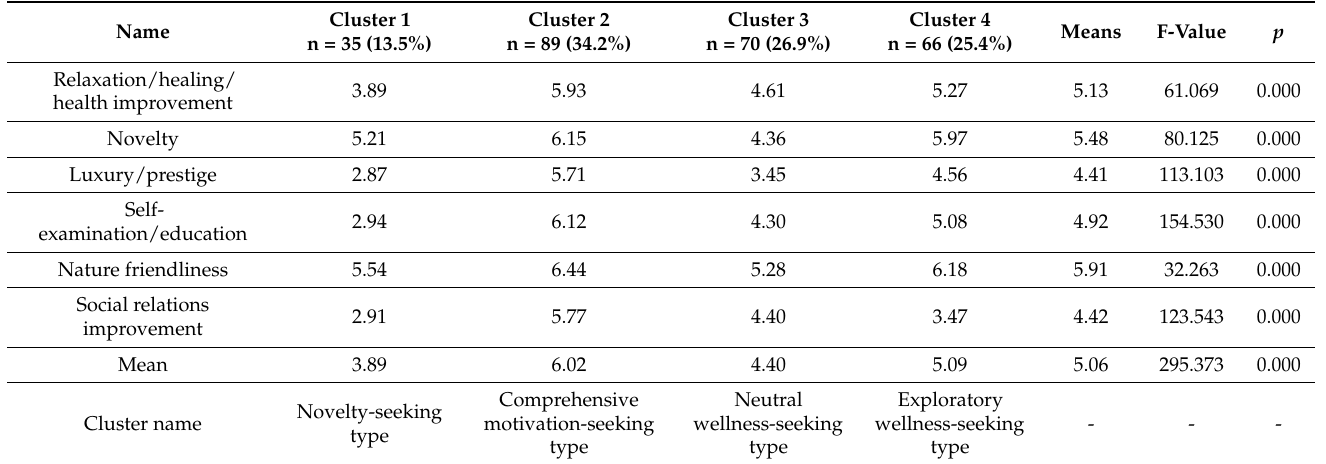
Table 11. Verification of differences between clusters according to wellness tourism participation